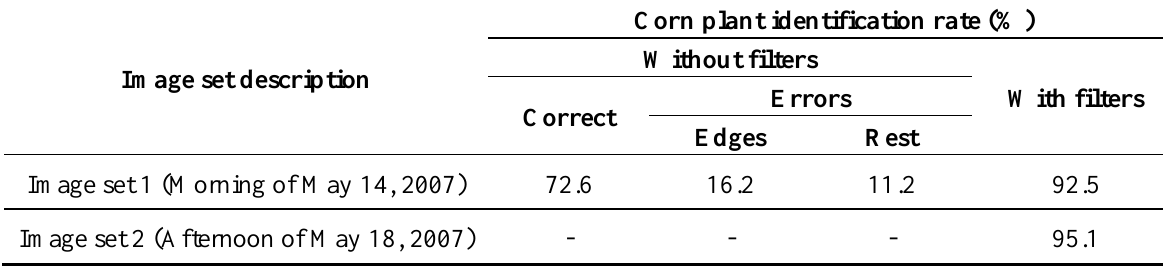
Table 2. Evaluation of the ANN’s performance on identification of corn plants.